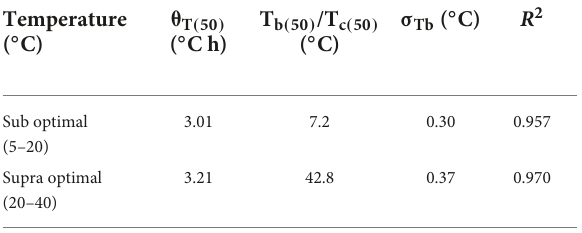
TABLE 1 Model parameters for thermal time model describing germination of Parthenium hysterophorus seeds at sub- and supraoptimal temperatures.